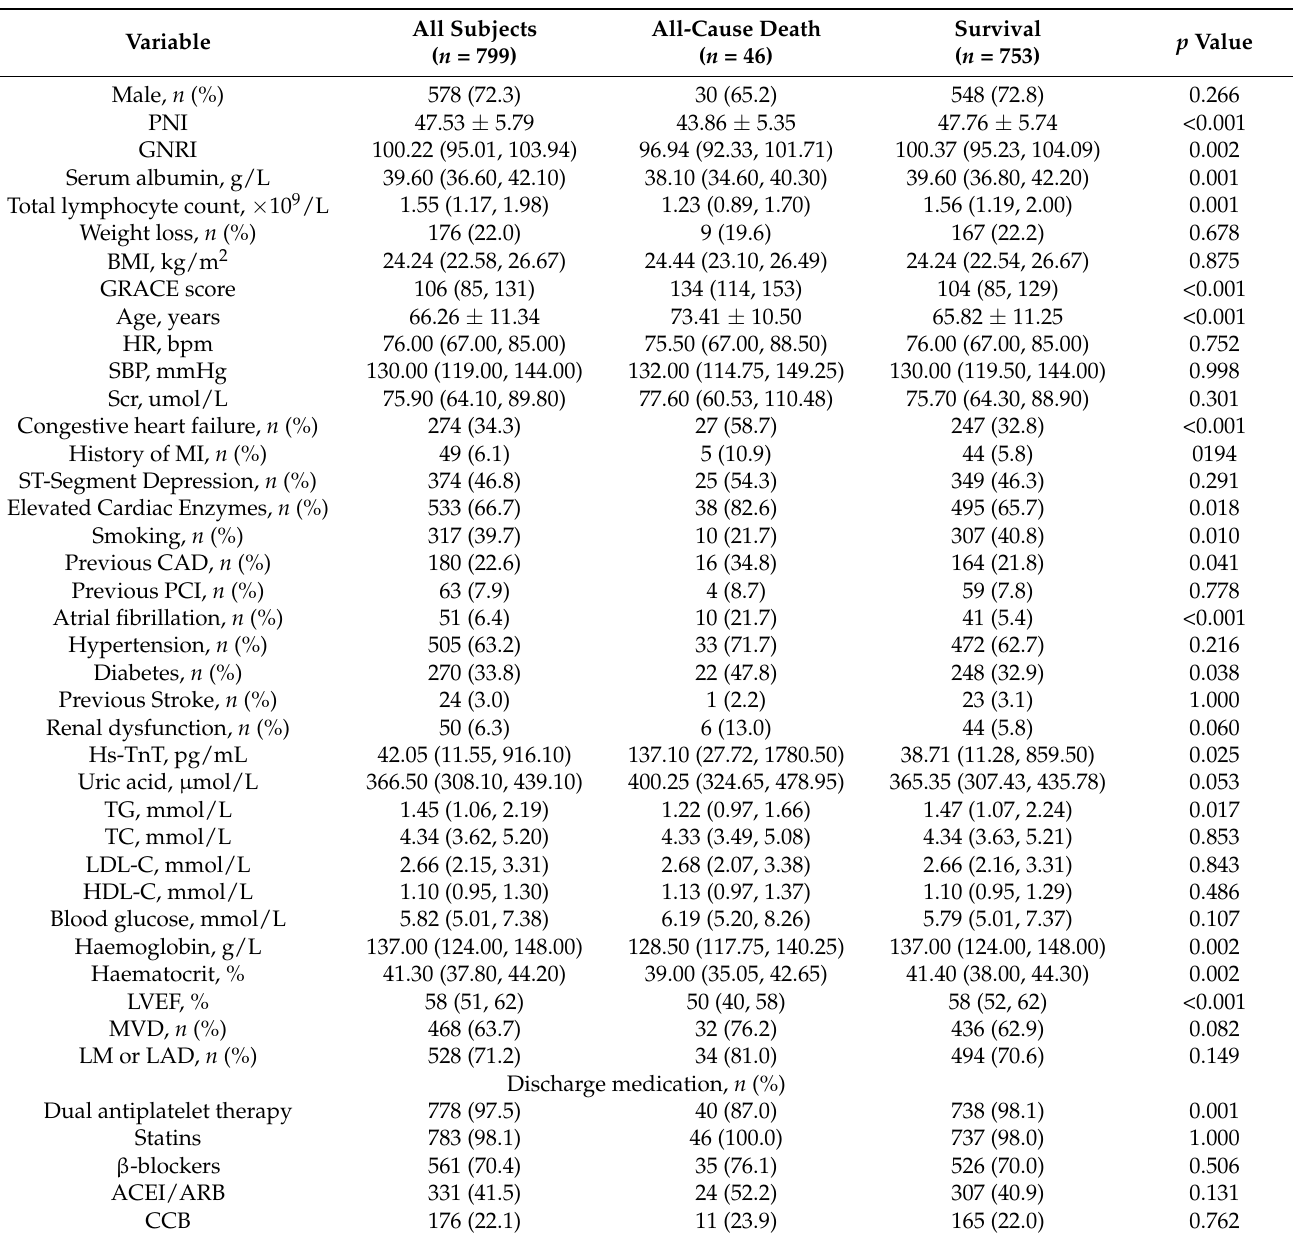
Table 1. Comparison of baseline characteristics of patients in the all-cause death group and the survival